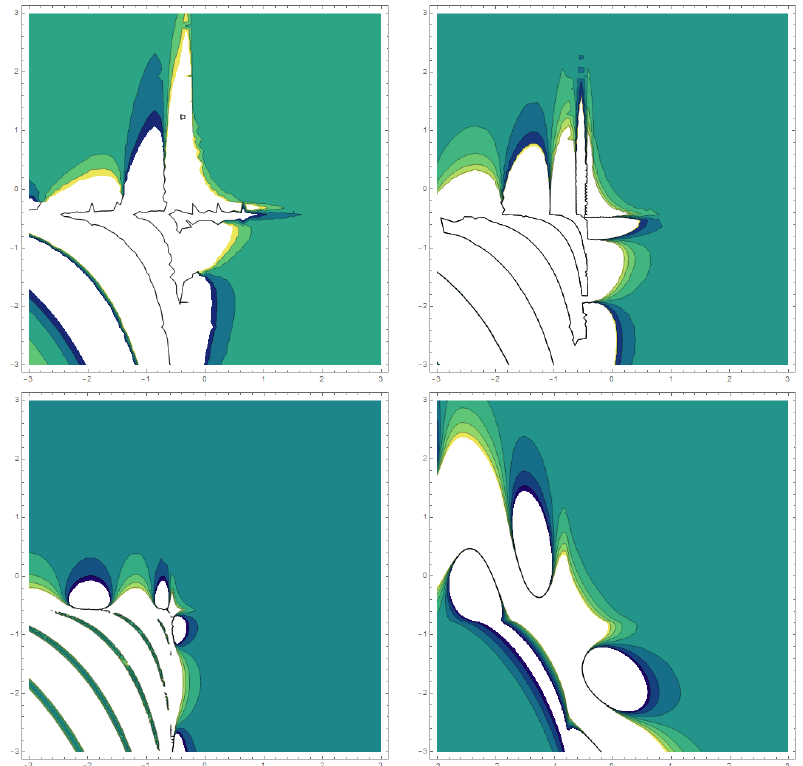
Figure 11. The 2D contour graphs of dark–bright solitary-wave solution, i.e., | L 18 | across different values of β .